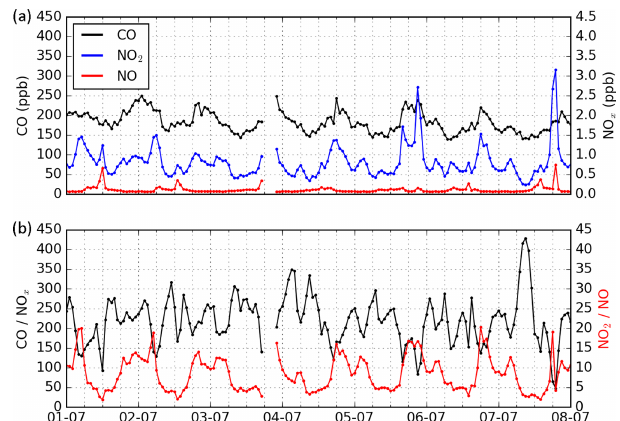
Figure 5. Time series of (a) carbon monoxide (CO), nitrogen diox- ide (NO 2 ), and nitrogen monoxide (NO) hourly concentration aver- ages (ppb) observed at Savè (Benin) for the period of 1–7 July 2016 and (b) of the ratios CO / NO x (in black) and NO 2 / NO (in red). The vertical dashed lines indicate periods of 6h starting at